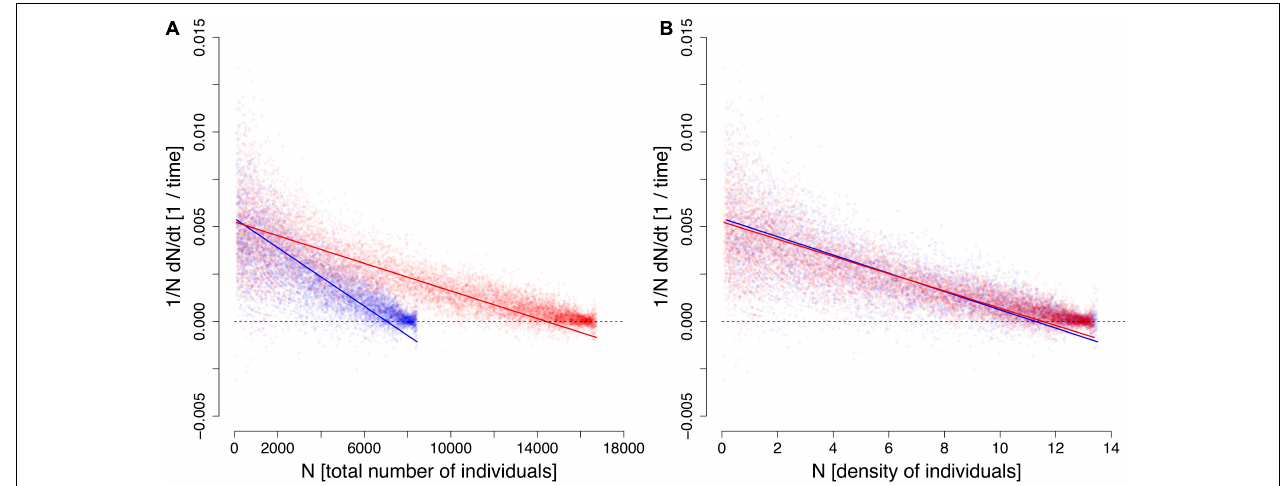
FIGURE 1 | Simulation results of the individual-based model run in a smaller habitat (blue) and in a twice as large habitat (red). The calculated per capita growth rate (Equation 14) is expressed (A) vs. absolute population abundance and (B) vs. population density. The lines are the results of type-II regressions; the slope’s absolute value is an estimate of the interspecific competition a (Equation